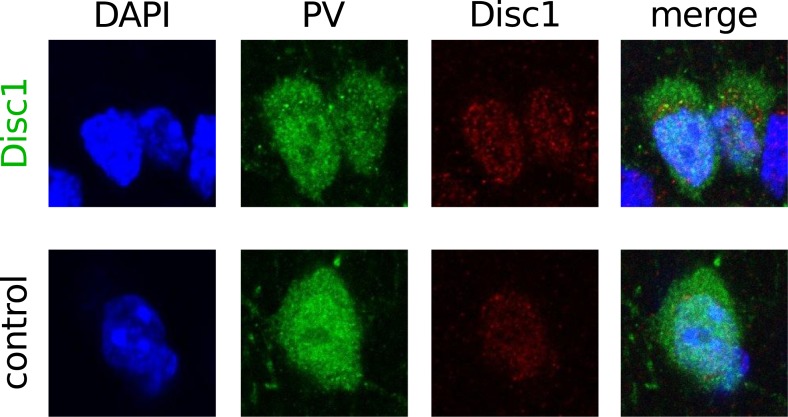
PV-positive INs express Disc 1.Confocal image stack of DAPI, PV and Disc1 stained-sections demonstrated expression of Disc1 in PV-positive neurons in the PrlC of Disc1 and control mice. Images are representative for 35 PV/Disc1-positive cells (of 39 tested PV-expressing neurons) in Disc1 PrlC and 15 PV/Disc1-positive cells (of 15 tested) in ctrl PrlC. p = 0.832. Image size: 20 µm.